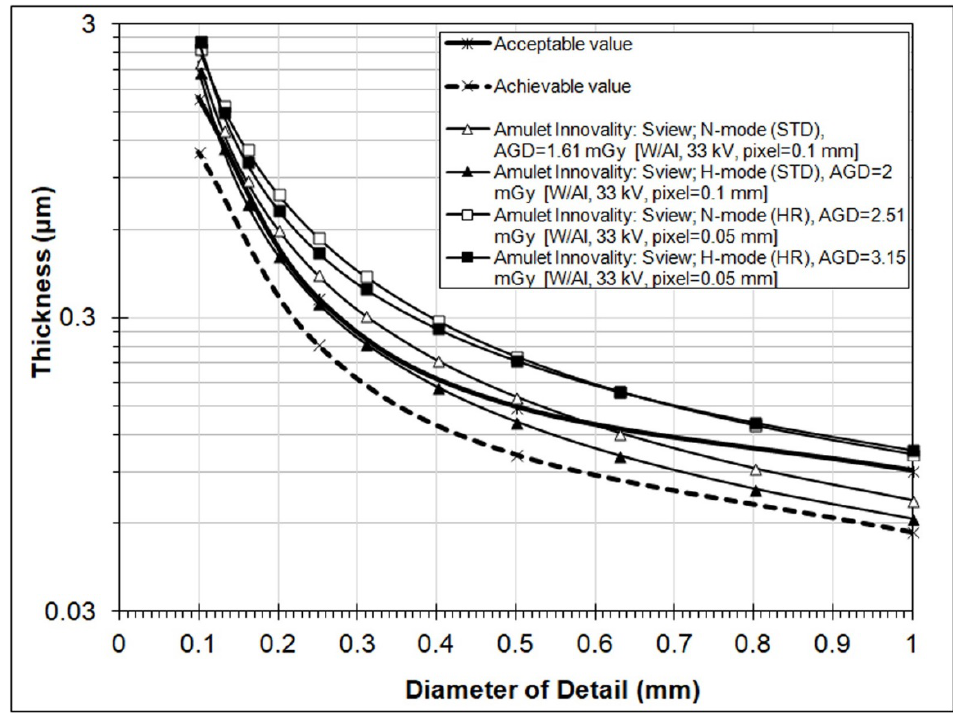
Figure 4. Contrast–detail curves for s2D (S-view) images obtained using four different operation modes (N-mode (ST), H-mode (ST), N-mode (HR,) and H-mode (HR)) for DBT acquisitions. (Results from the CDMAM3.4 Analyser software.)